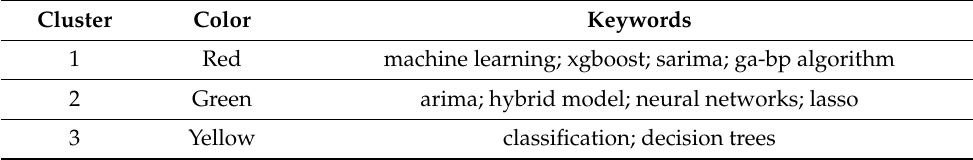
Table 5. Selected clusters of keywords co-occurrences presented in Figure